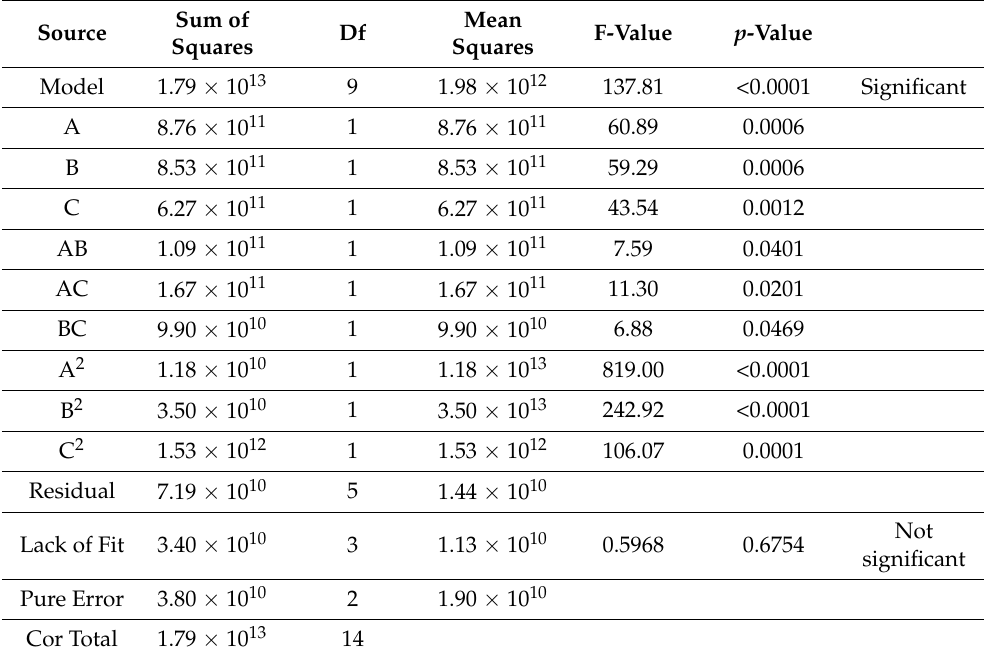
Table 2. ANOVA for the response surface quadratic model (Cor Total: Corrected Total Sum of